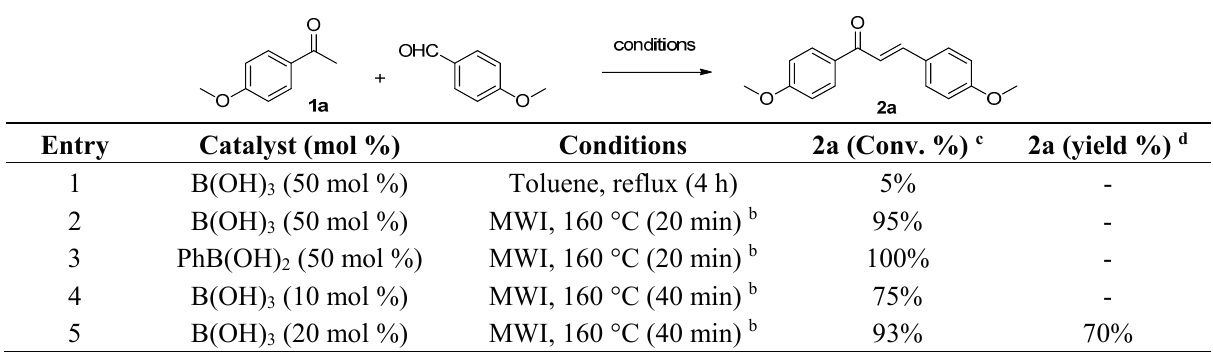
Table 1. Optimization of the condensation reaction catalyzed by boric acid a